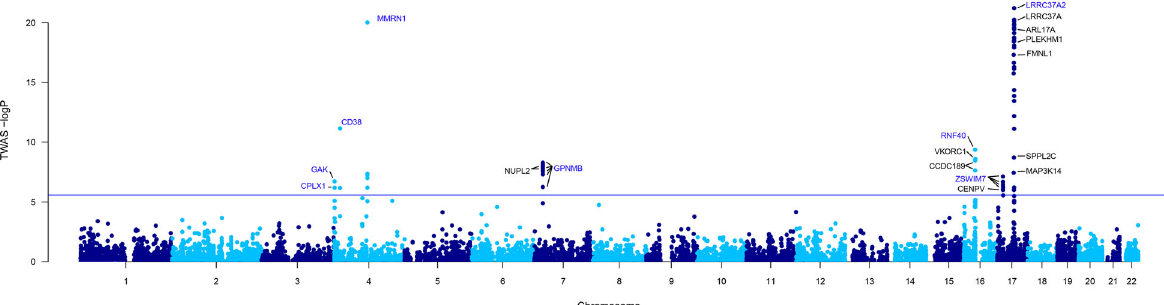
Fig. 2 Manhattan plot of the TWAS results for PD. The blue line represents the Bonferroni-corrected signi fi cant thresholds, P = 2.55 × 10 − 6 . Conditionally independent genes are listed in blue